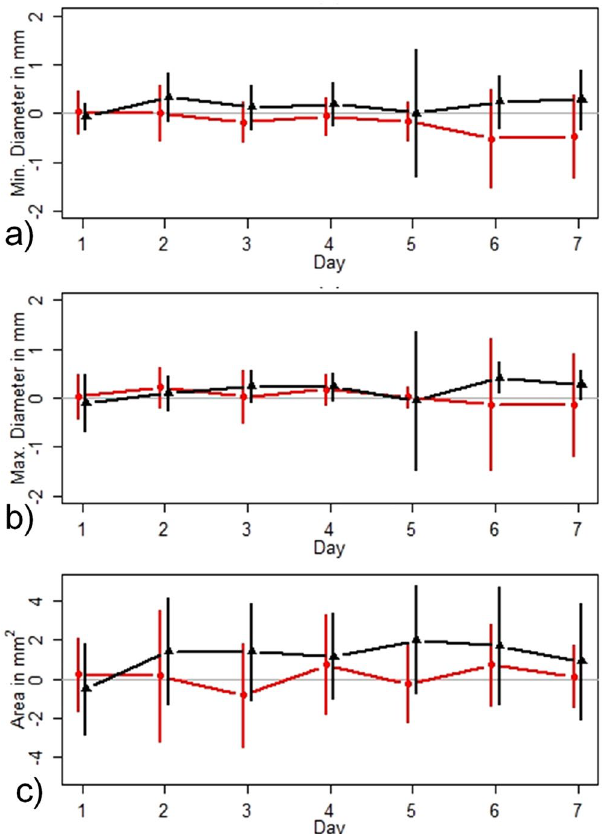
Figure 4. Effect of APOSEC on wound healing. Mean progression as well as the standard deviation (vertical lines) of minimal ( a ) and maximal ( b ) diameters and area ( c ) of the artificial wound during 7 days, represented as the difference of APOSEC – placebo. (red, group A = low-dose group; black, group B = high-dose